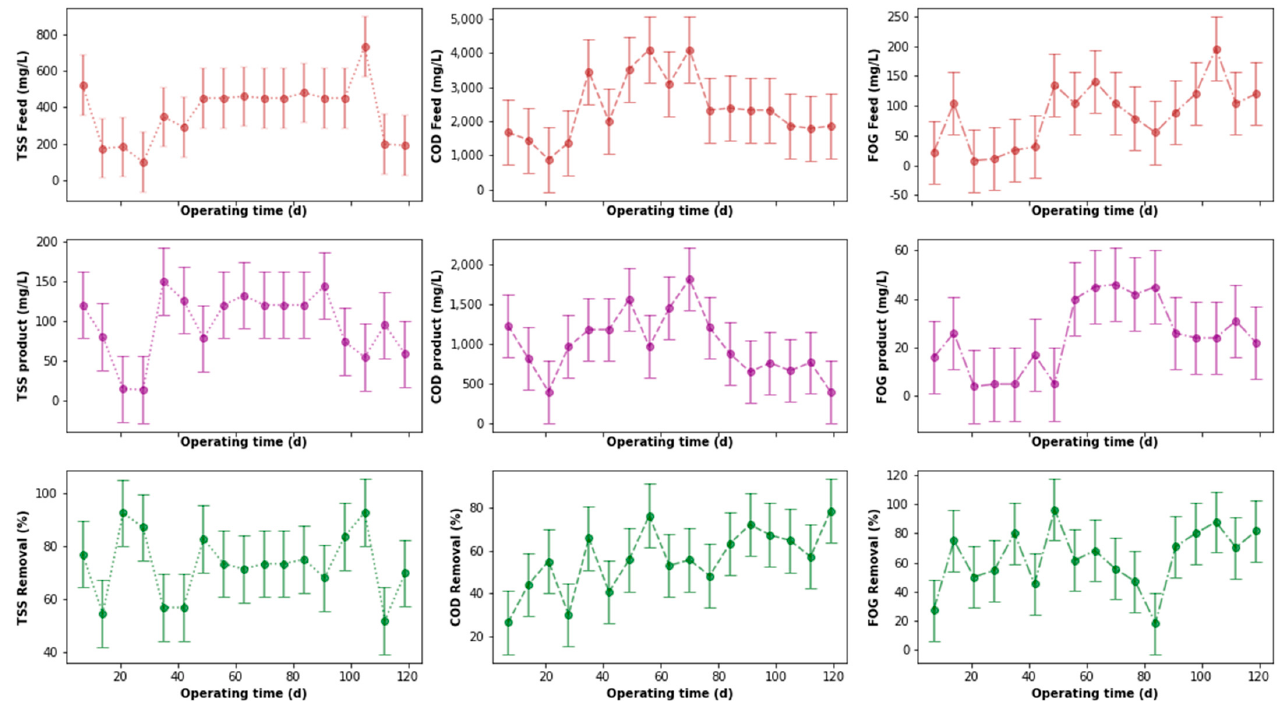
Figure 11. EGSB Treatment performance after anomaly detection and correction.